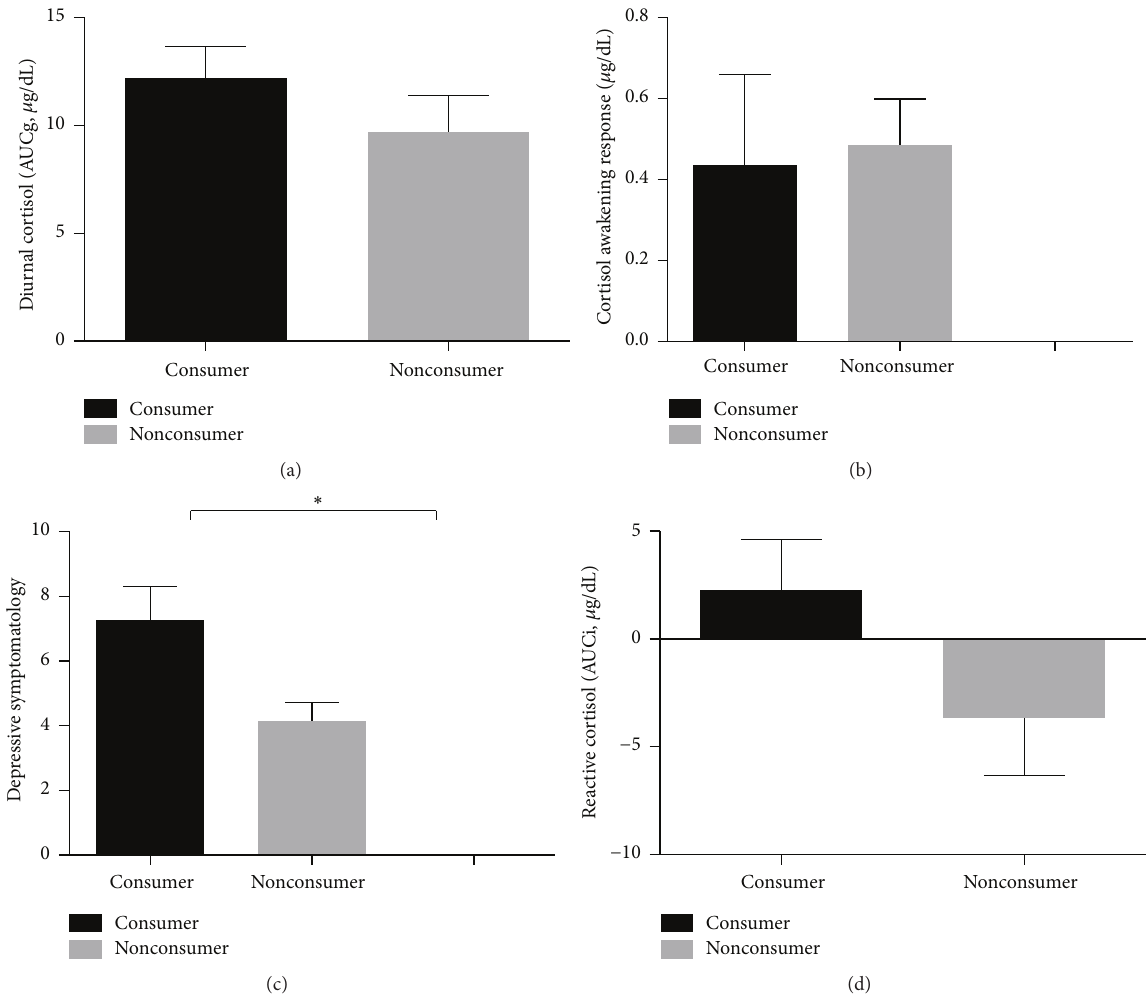
Figure 2: (a) Diurnal salivary cortisol levels (AUCg) as a function of consumer group. (b) Cortisol awakening response as a function of group. (c) Reactive salivary cortisol levels (AUCi) in response to the Trier Social Stress Test as a function of group. (d) Depressive symptomatology as a function of group. The asterisk ( ∗ ) means 𝑃 < 0.05 . For all figures, the error bars represent the standard error of the mean adjusted for sex and body mass index.